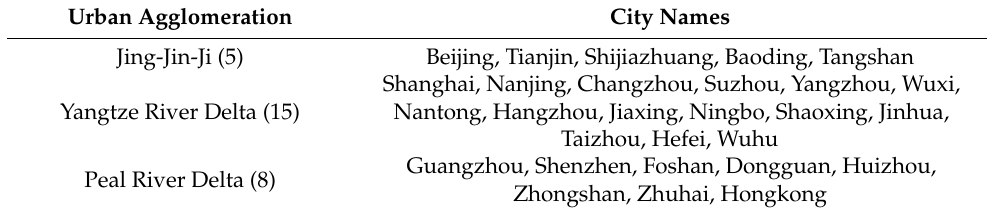
Table 1. Cities in three urban agglomerations.